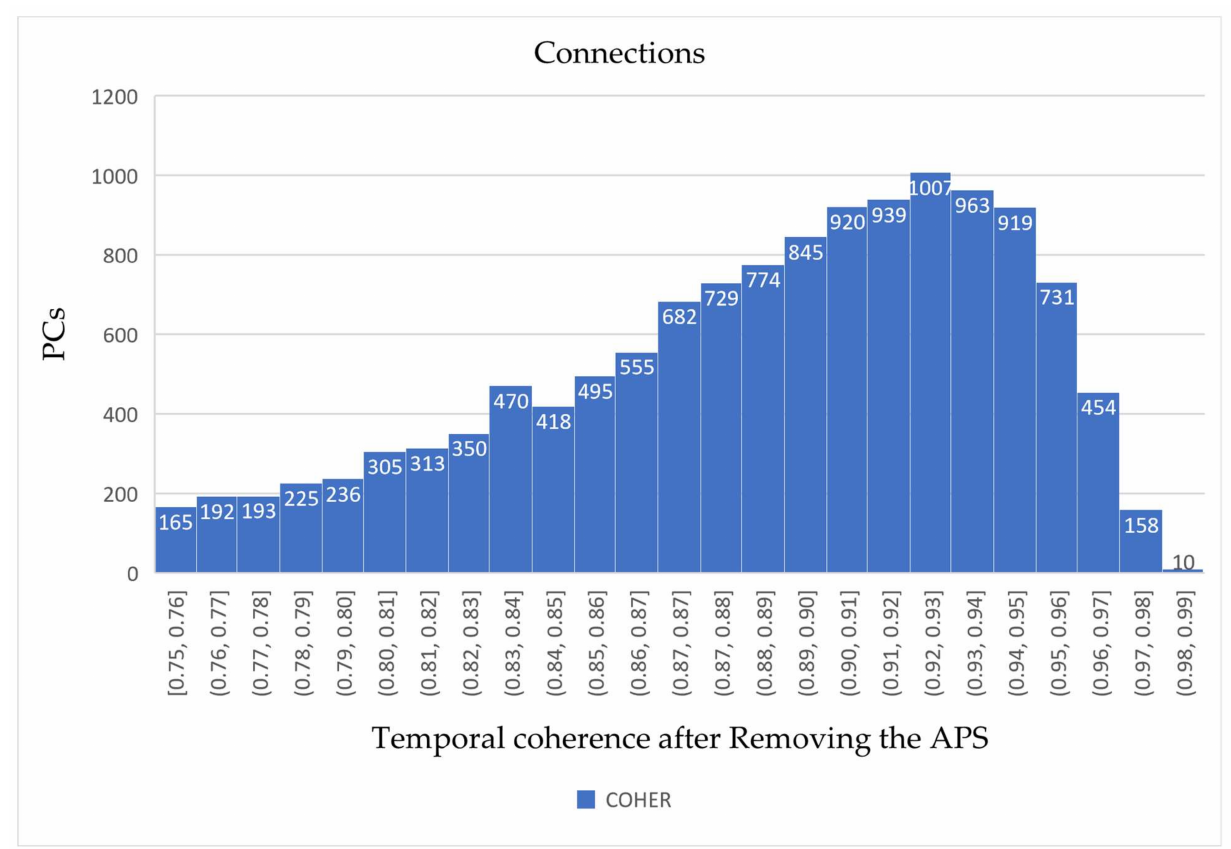
Figure 4. PSs coherence values after the APS